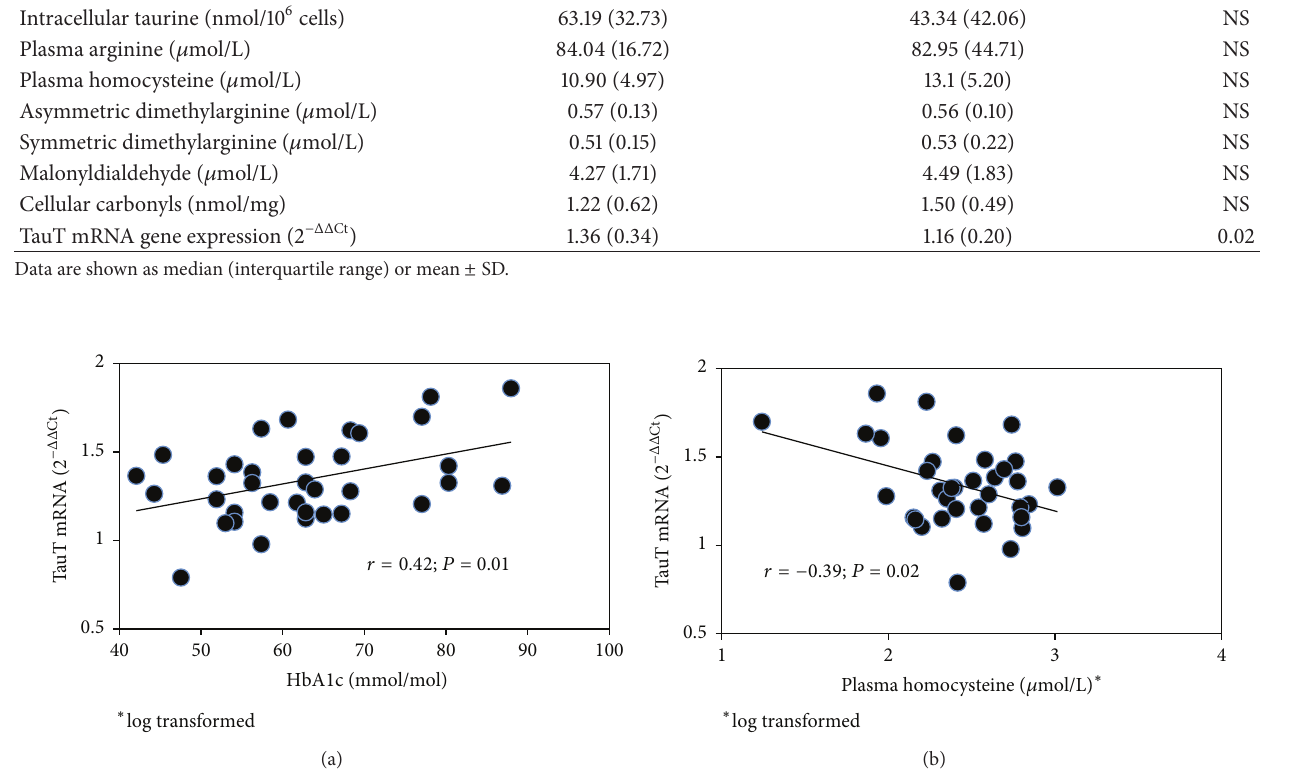
Figure 3: Relation between TauT mRNA gene expression and HbA1c (a), or plasma homocysteine (b), in MPCs from type 1 diabetic